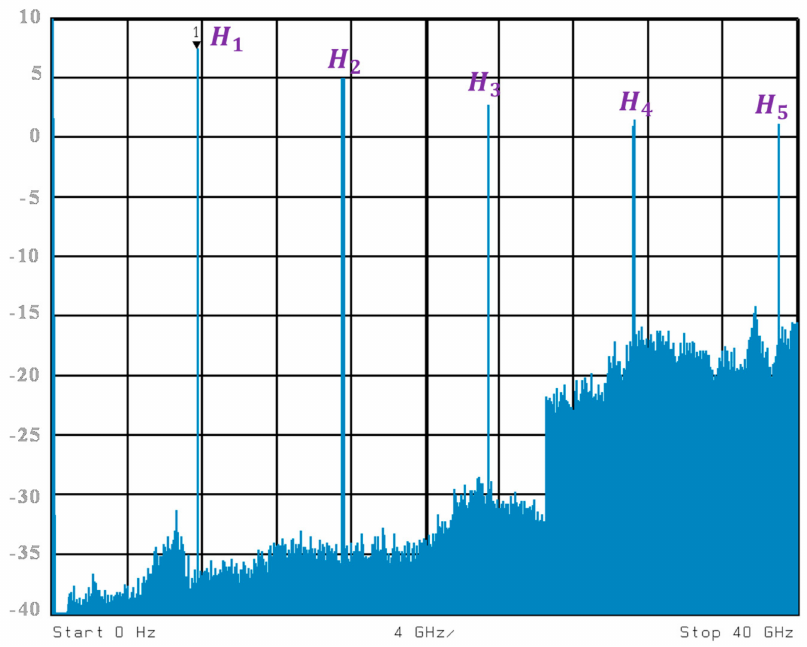
Figure 7. The first five harmonics of the electrical spectrum of the OPS at a repetition rate of 7.8